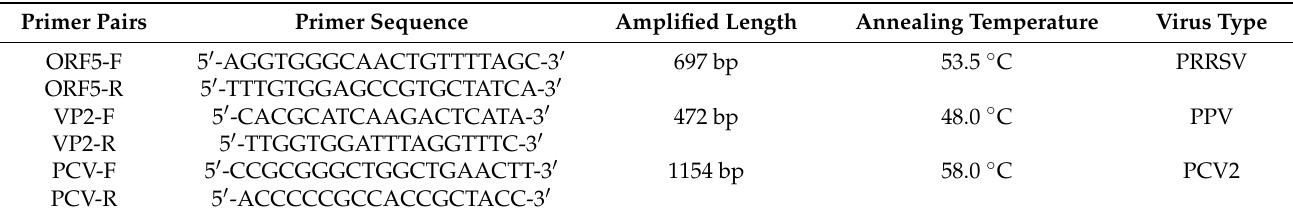
Table 1. Primer sequence used in study for virus screening through PCR. Primer Pairs Primer